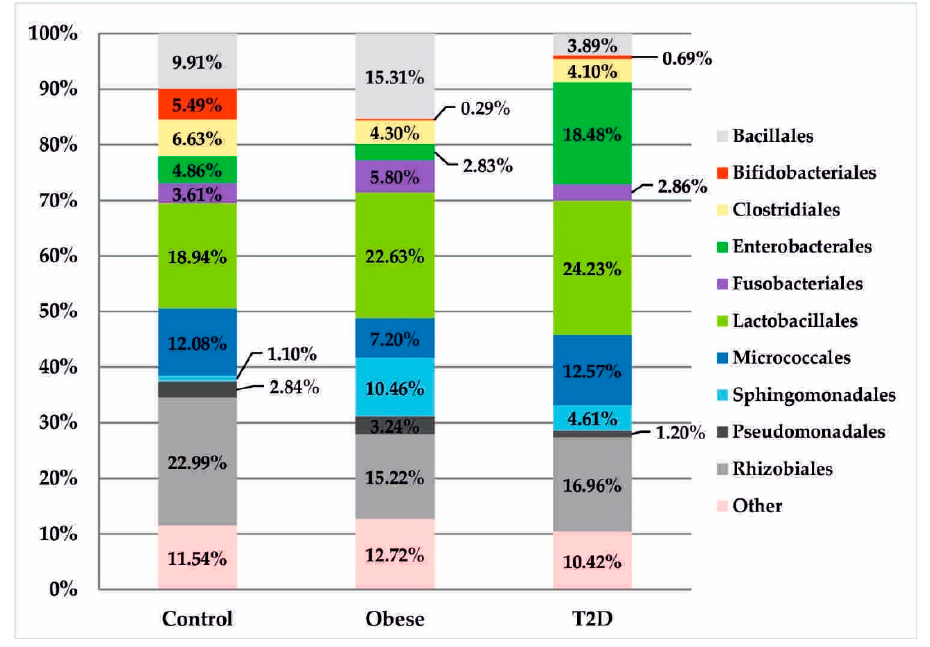
Figure 4. Bacterial profiles in the treatment and control groups at the order level.